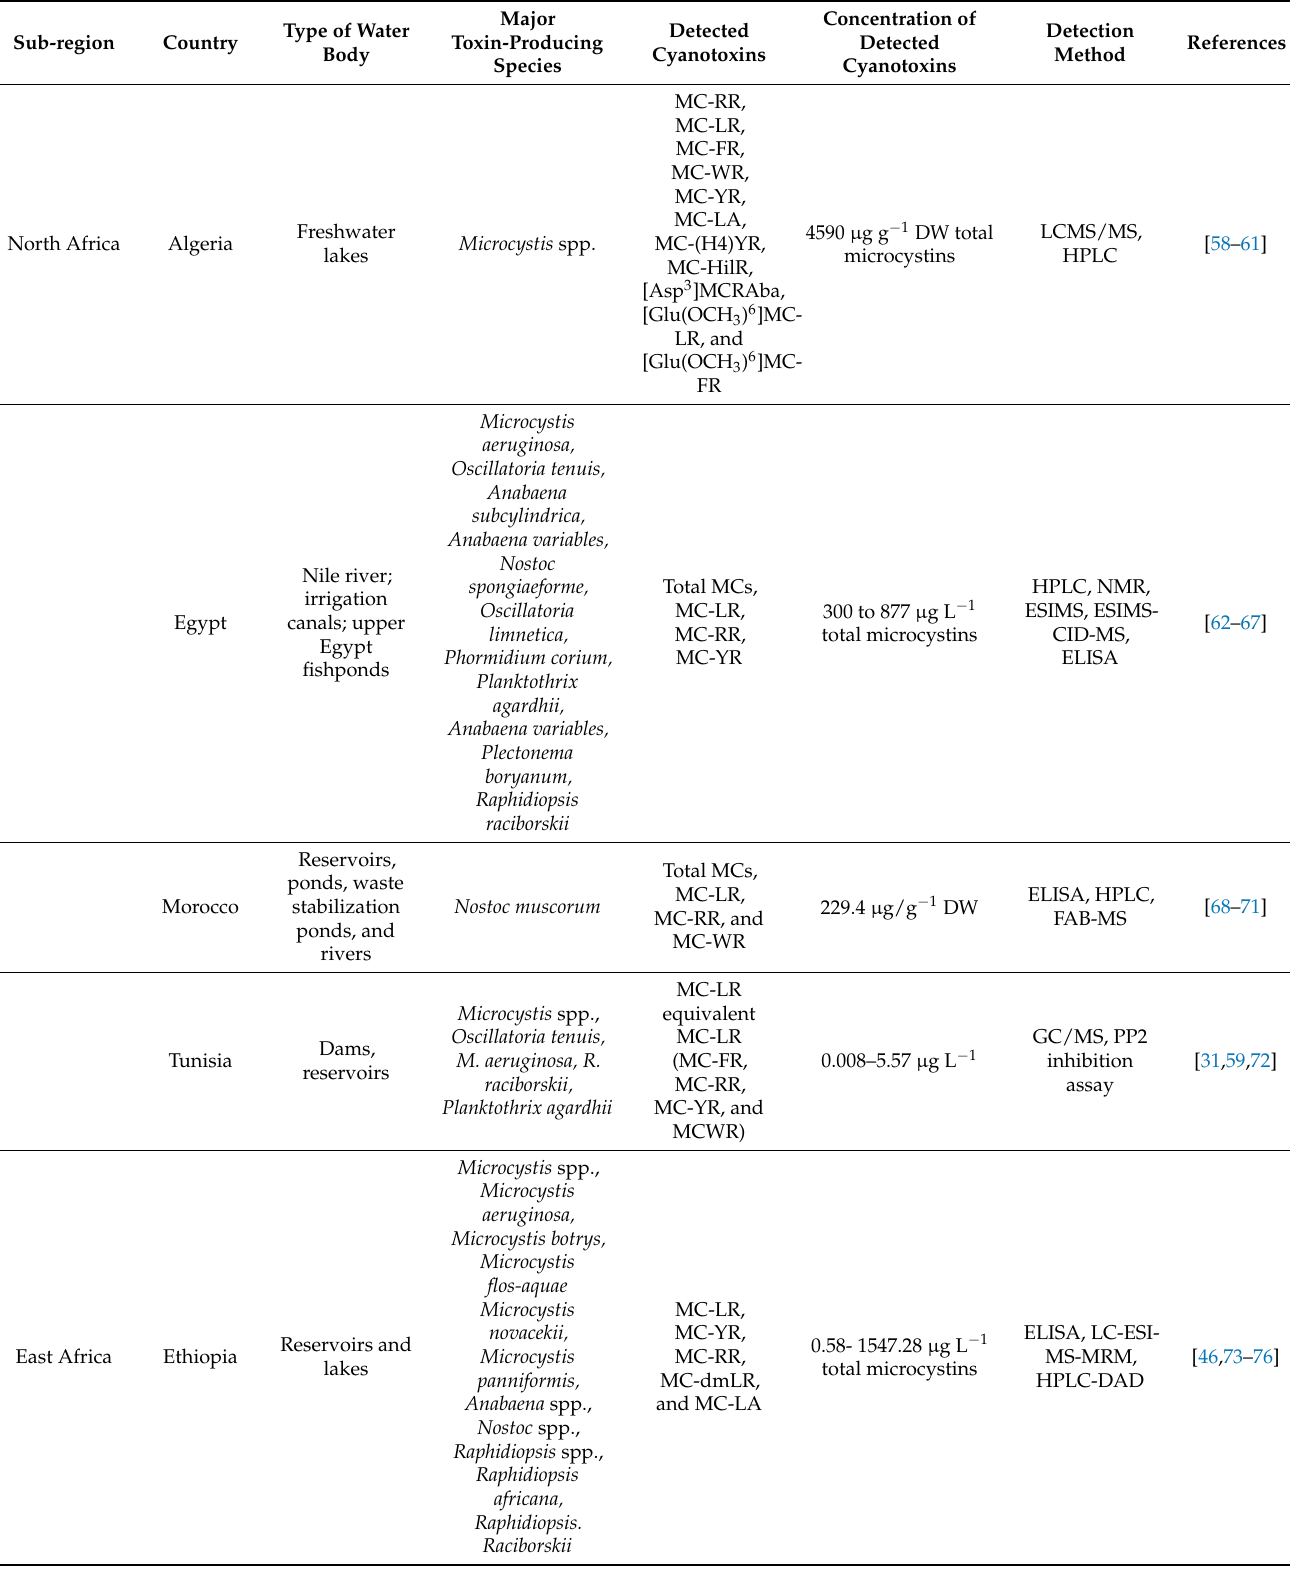
Table 3. Diversity of microcystin congeners recorded in different aquatic ecosystems in